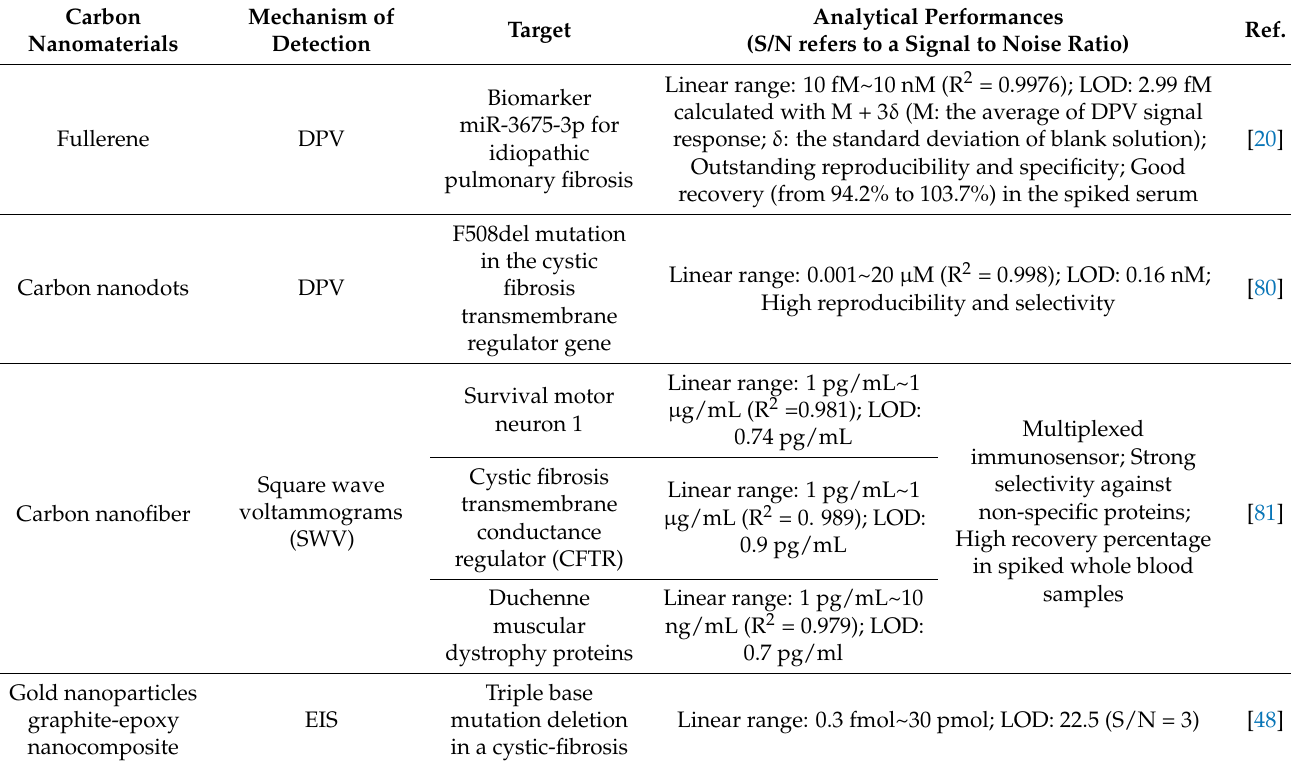
Table 3. Performances of electrochemical biosensors for fibrosis